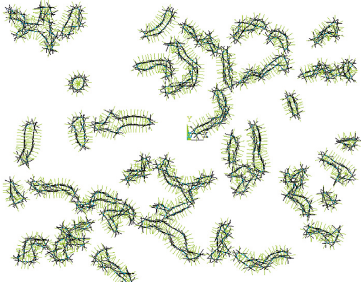
Figure 4: Interfacial